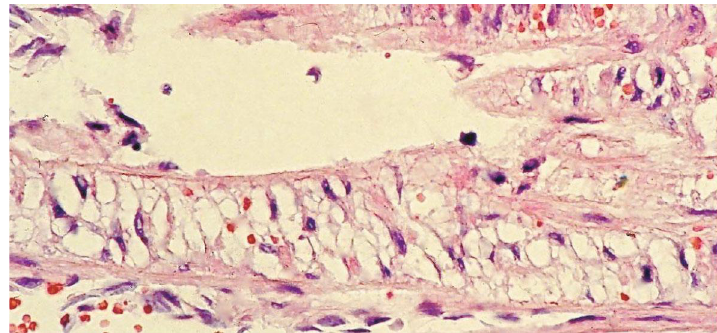
Figure 4: Segmental arterial mediolysis, injurious phase. The arrow points to a longitudinal section of the coronary artery exhibiting transmural cytoplasmic hydropic change. The cell membranes of many scattered swollen myocytes are intact although some are disrupted. Hematoxylin & eosin × 200 (adapted from EC Cardiology 4(7) 2918, online